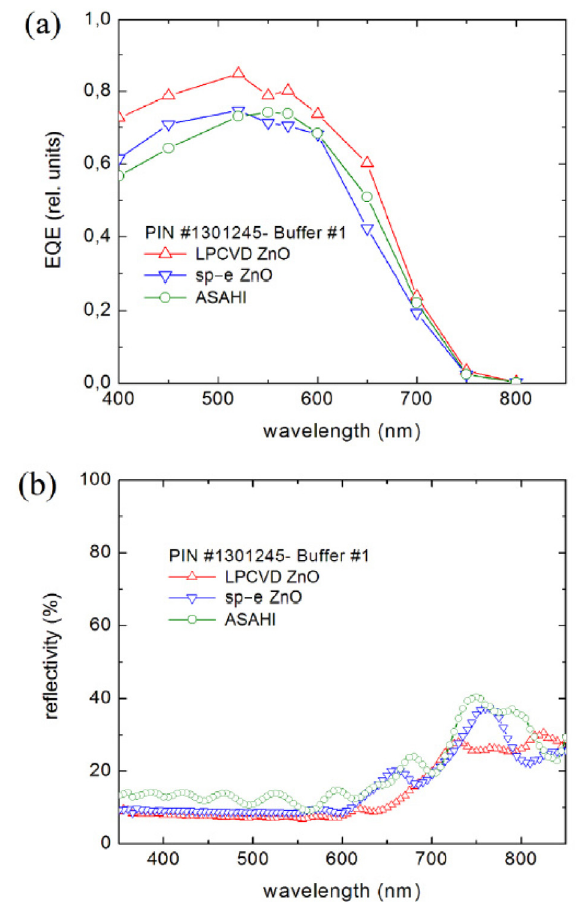
Fig. 4. External quantum efficiency of pm -Si:H solar cells with the same p - i - n/ metal contact configuration fabricated on three different TCO substrates. A thin a -Si:H buffer layer is used at the p/i interface. The cells are measured in their initial